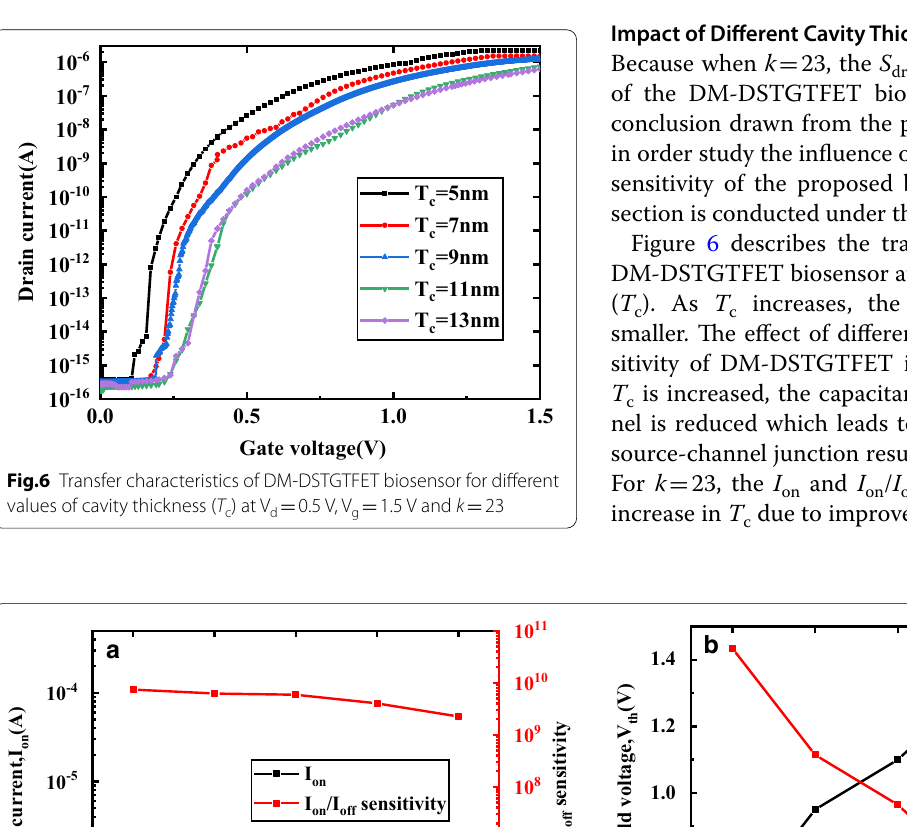
Fig.5 a Subthreshold slope, subthreshold slope sensitivity and b drain current sensitivity with different biomolecules when V d and V g 1.5 V =